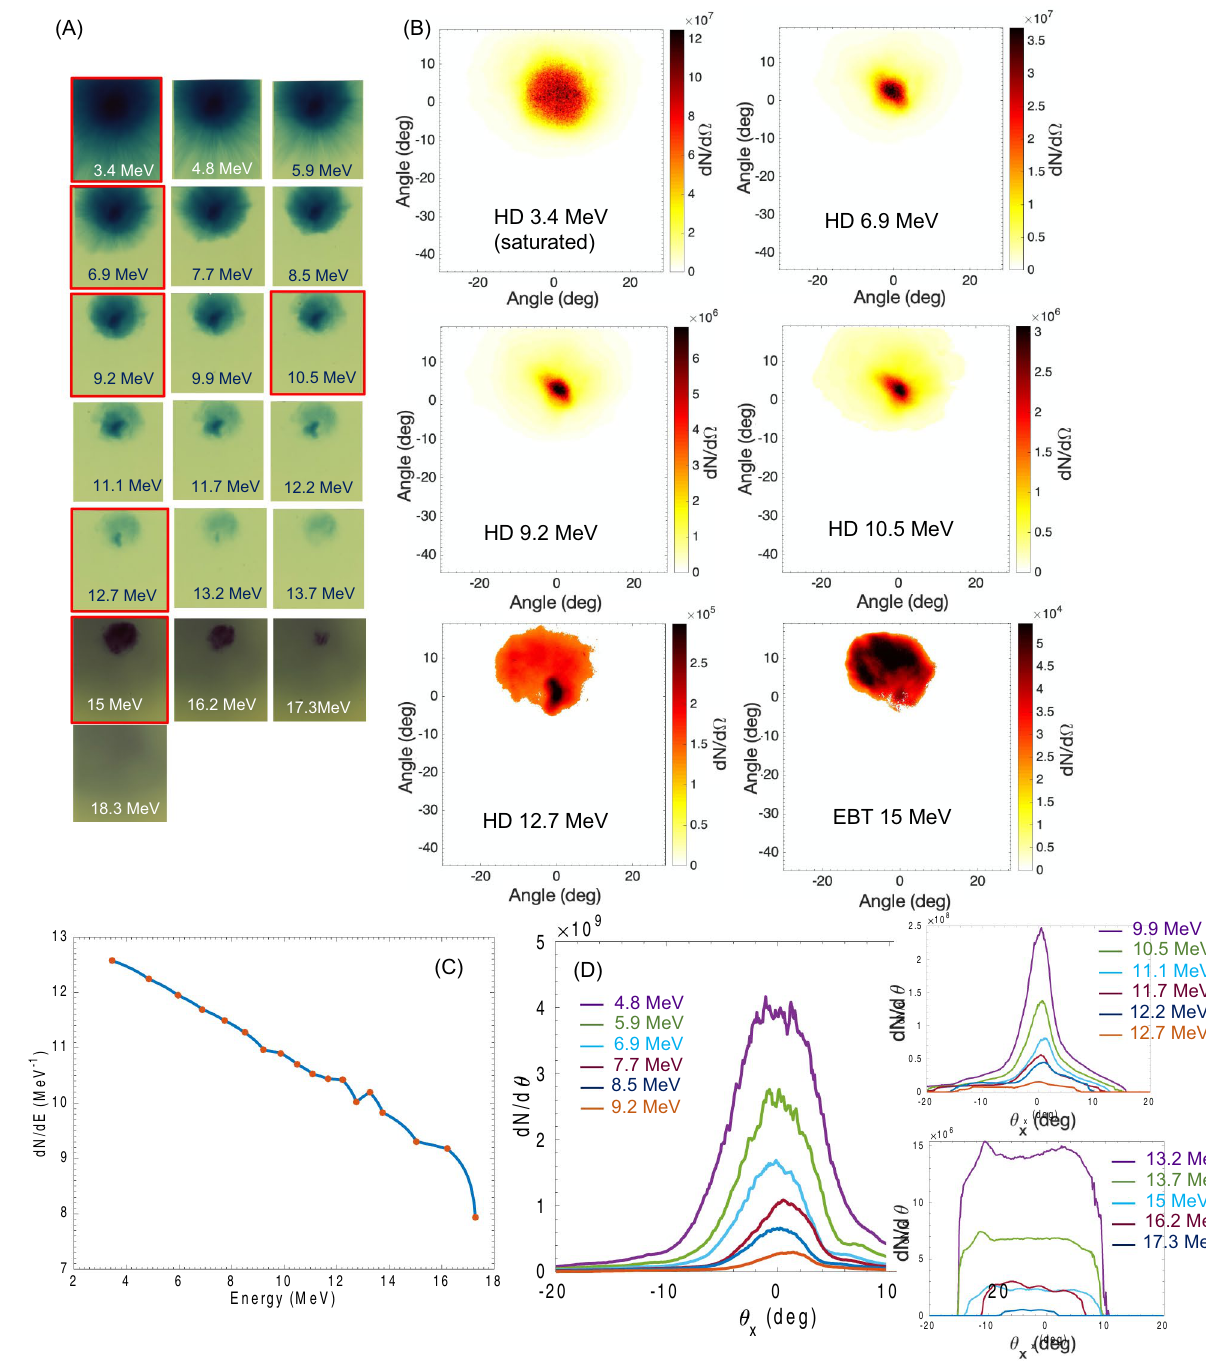
Figure 3. Example of experimental and post-processed data for tip-less buried cone target. ( A ) Raw RCF data showing the proton beam distribution tip-less buried cone target. The RCF film corresponding to the post processed data in ( B ) are framed in red. ( B ) Selection of post-processed data from the measurement in ( A ). It is evident the presence of a highly collimated proton beam component up to 13 MeV, characterized by divergence angles comprised between 11 degrees at low energy and 6.5 degrees at higher energy. Measurement on the first two RCF foils, corresponding to energies of 3.4 and 4.8 MeV is more difficult due to RCF saturation in the green channel at the beam center. For Energies exceeding 13 MeV the collimated component fades and gives place to a broader distribution with significantly higher divergence, starting at about 25 degrees, and reducing for higher energies similarly to typical TNSA proton beams. ( C ) Proton energy spectrum calculated from the spectral unfolding of the RCF data. ( D ) Proton beam angular distribution for all energies, clearly showing a divergence ≤ 11 degrees for proton energies between 4.8 and 9.8 MeV. The enclosed plots represent the angular distribution for (up) the mid-energy component, showing that the collimation is maintained till 12.7 MeV and the high high-energy component, with higher divergence (down) typical of classic TNSA proton